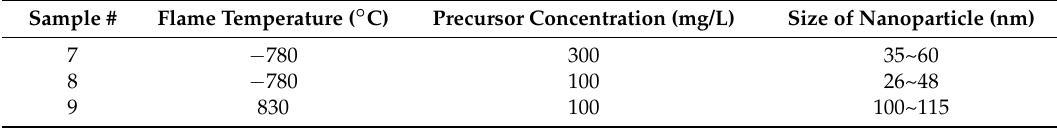
Table 3. Nanoparticle size with varying conditions.